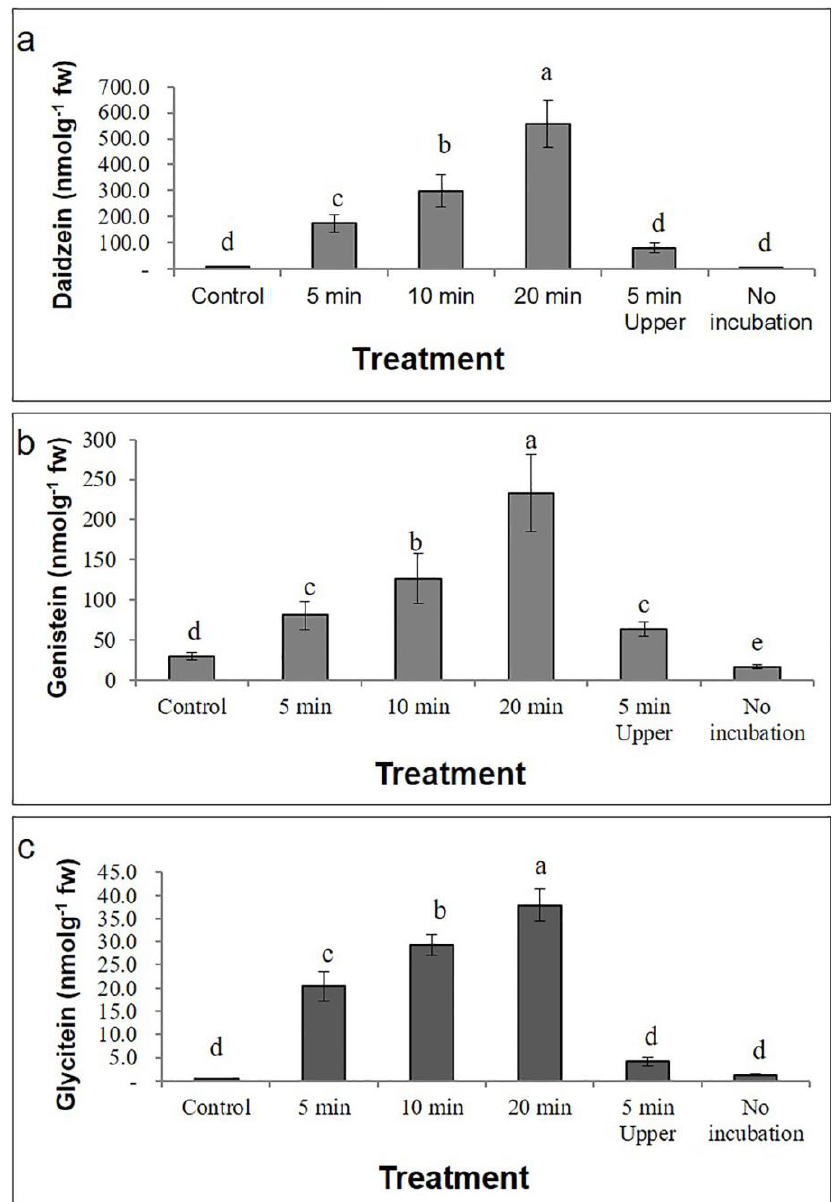
Figure 5. Concentrations of the aglycone compounds ( a ) daidzein, ( b ) genistein, and ( c ) glycitein in G. max cv. Daepung after UV-C irradiation for di ff erent time periods (unit: nmol g − 1 of fresh weight). The treatment without UV-C irradiation and without incubation is indicated as “no incubation”. The error bars represent the means ± standard deviation ( n = 3). Means with the same letter are not significantly di ff erent ( p ≤